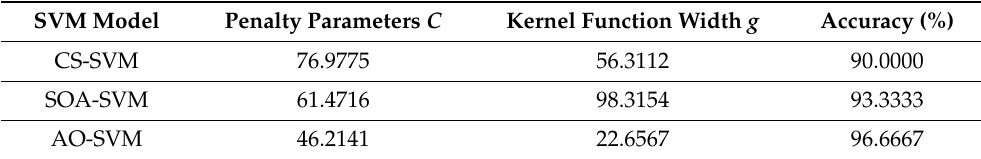
Figure 13. Comparison of identification results of three SVM algorithms: CS ‐ SVM, SOA ‐ SVM, and AO ‐ SVM. Table 3. Comparison of SVM optimization algorithms.